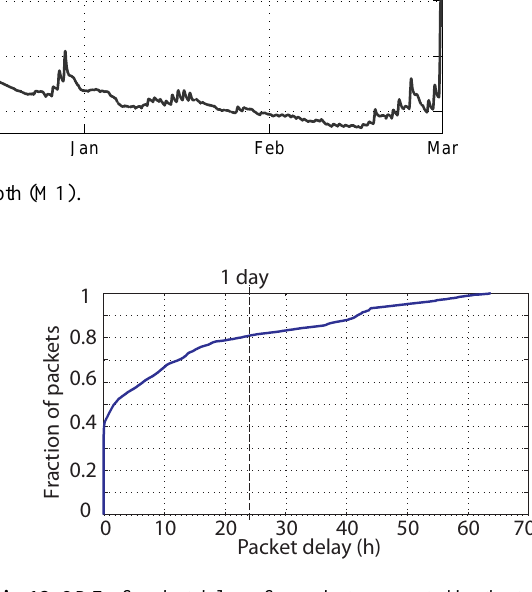
Fig. 13. CDF of packet delays, for packets generated by the two AE- nodes. More than 80% of all packets are forwarded to the network sink in less than